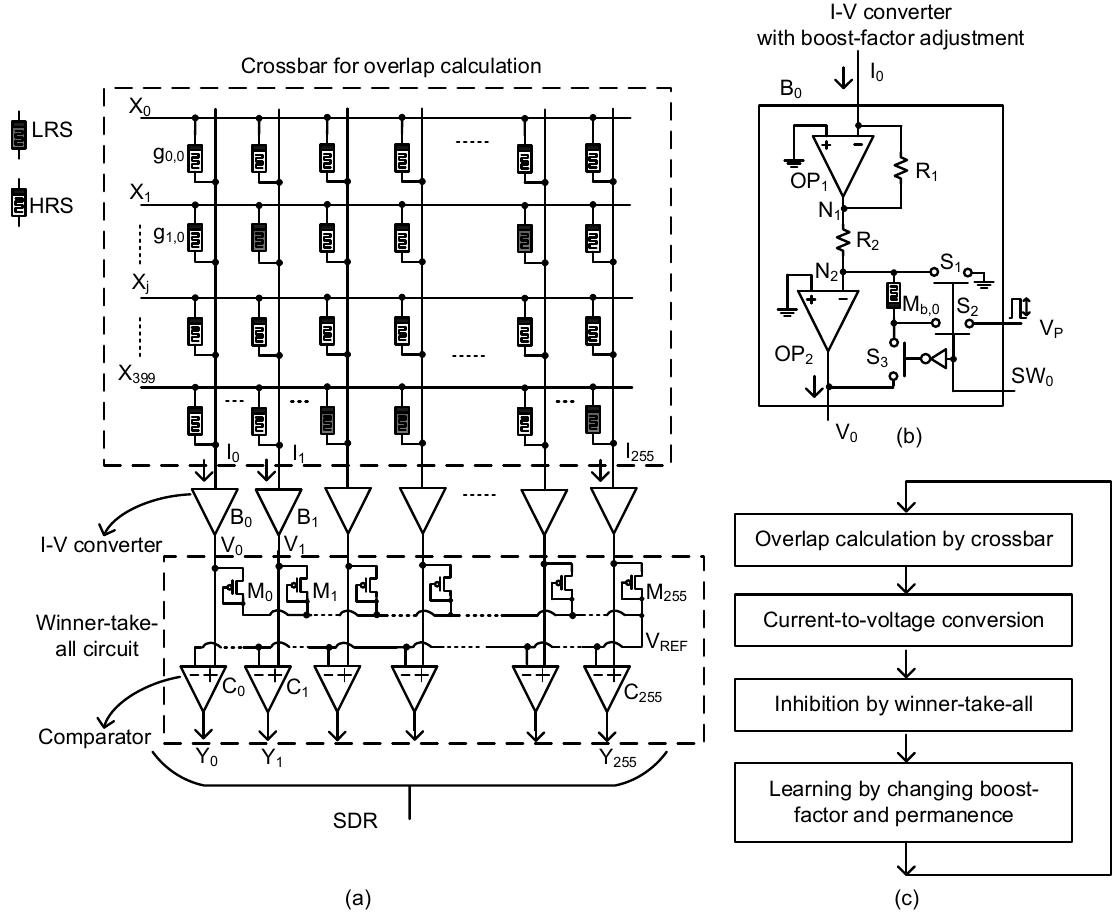
Figure 6. ( a ) The detailed schematic of the memristor-CMOS (Complementary Metal-Oxide-Semiconductor) hybrid circuit of defect-tolerant spatial pooling. The hybrid circuit is composed of the memristor crossbar, the current–to-voltage (I–to-V) converters with the boost-factor adjustment, and the winner-take-all circuit with the diode-connected Metal-Oxide-Semiconductor Field-Effect Transistors (MOSFETs) and comparators; ( b ) the detailed schematic of the voltage-converter circuit with the boost-factor adjustment; and ( c ) the operational diagram of the memristor-CMOS hybrid circuit.